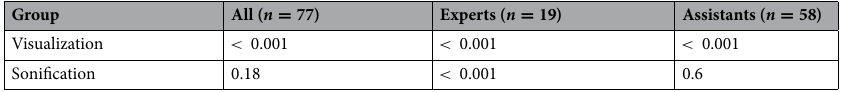
Table 4. The P values of the Wilcoxon signed-rank tests on the alignment time of the 1st. and 2nd. executions.